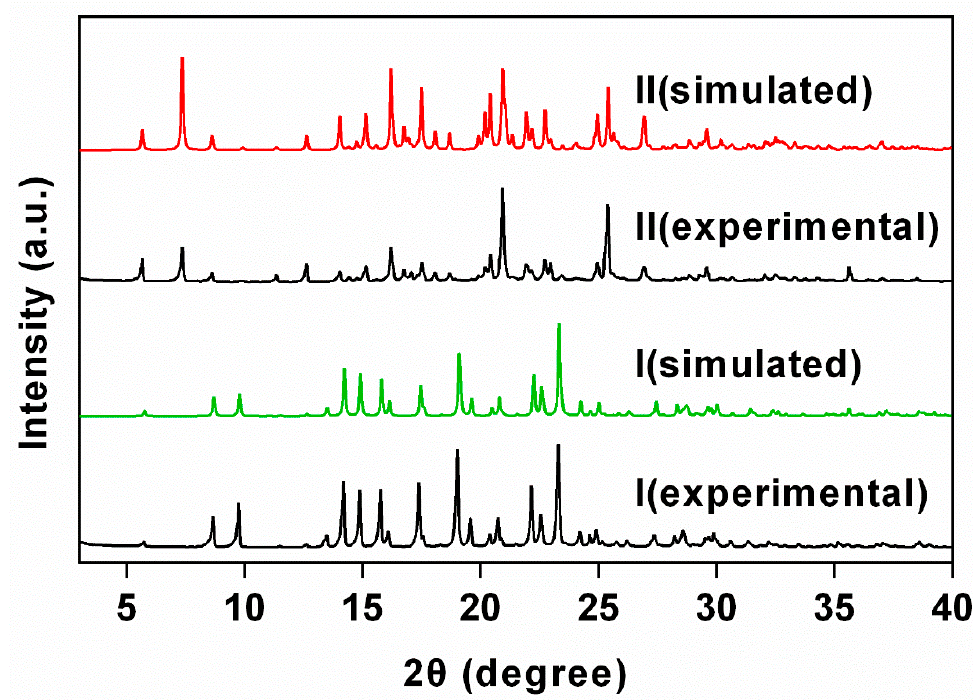
Figure 1. PXRD patterns of I and II showing a good agreement between the experimental and those simulated from single-crystal diffraction data and thus high phase purity of I and II .